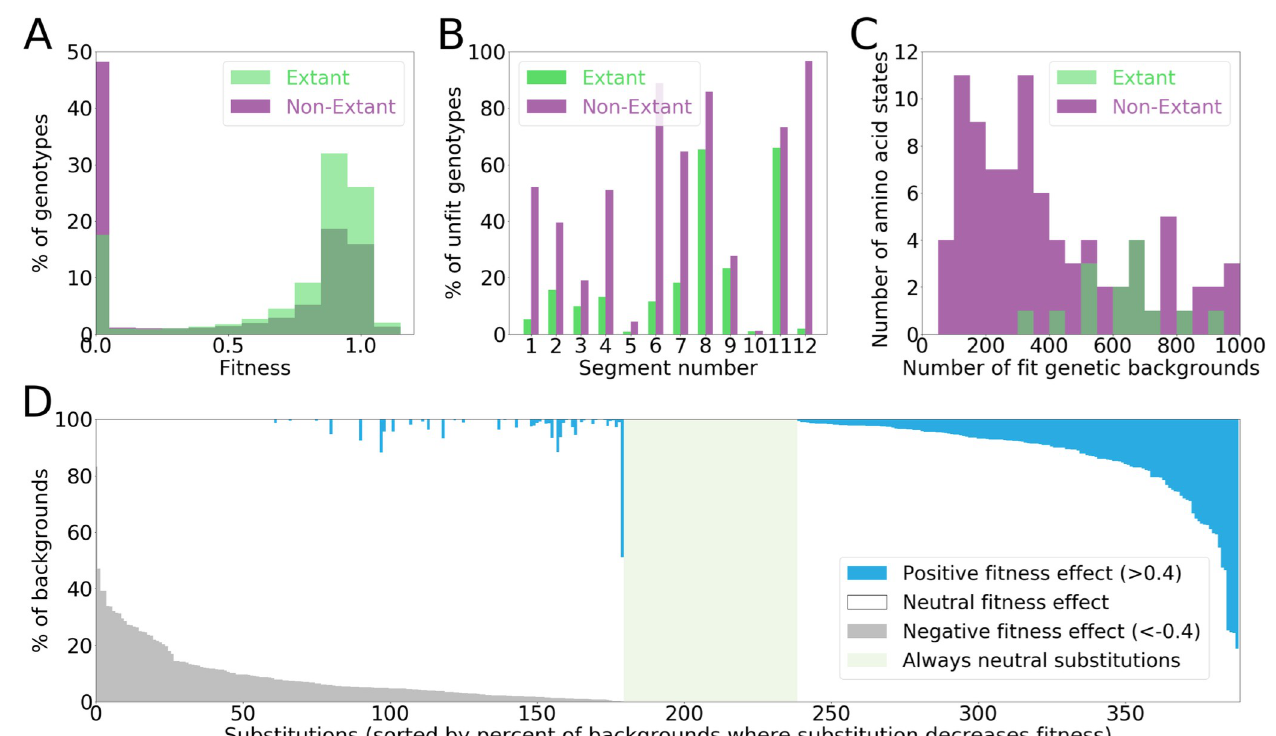
Fig 3. Fitness distributions. a, the distribution of fitness for genotypes composed of combination of extant amino acid states (green) and non-extant amino acid states (purple) at the same positions. b, The fraction of unfit genotypes per segment among genotypes consisting entirely from extant amino acid states (green) and those incorporating non-extant amino acid states (purple). c, Amino acid states can be found in a different number of fit backgrounds. In this figure, we show the number of amino acid states that were found in the lowest number of fit genetic backgrounds. Some non-extant amino acid states were found in just a few genotypes with high fitness. The most infrequent extant amino acid state was found in at least 300 different genotypes that had high fitness. d, The percent of backgrounds in which a specific amino acid replacement is neutral (white), beneficial (dark blue) or deleterious (dark grey). The region marked in green shows amino acid replacements that never have large effects ( > 0.4) on fitness. Beneficial and deleterious effects are shown only if the frequency for a given amino acid replacement was higher than the false discovery rate (S2 Supporting Information). Data from segment 9 were excluded for this